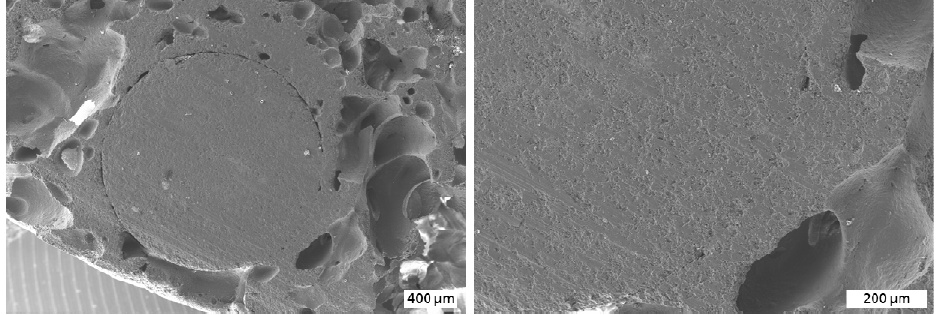
Figure 8. SEM fractured and cross-section view of gap interface of VPP column and Freeze Foam: magnification/HFW 35×/3550 μ m ( left ); 100×/1109 μ m ( right ); 8 kV acceleration voltage.